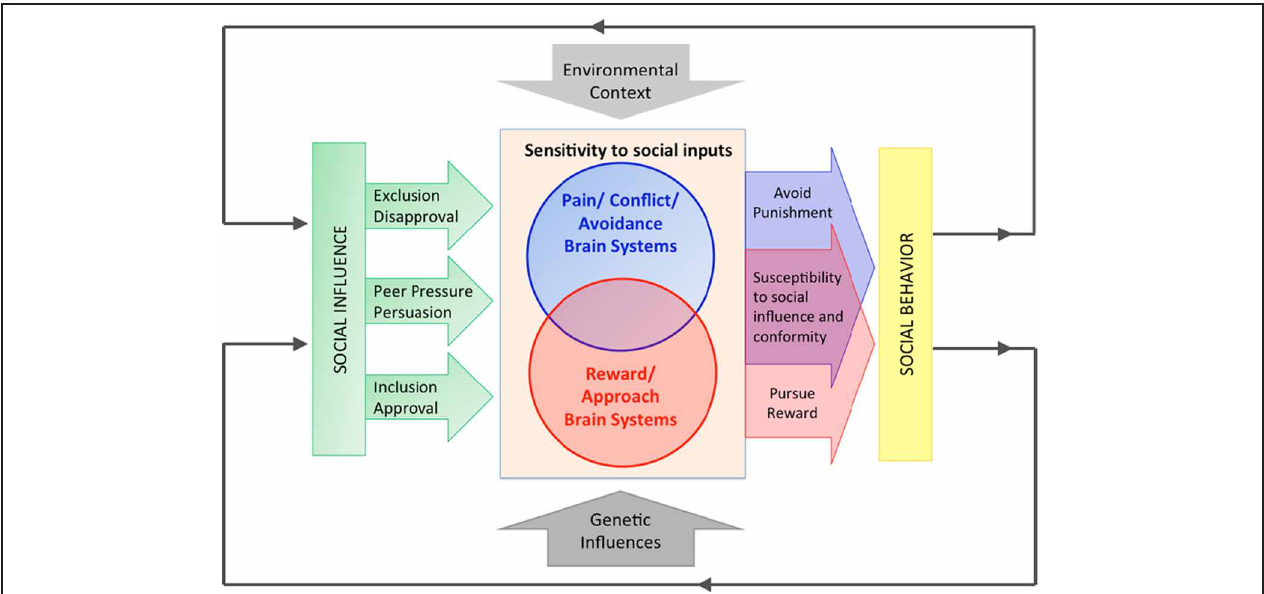
and genetic overlap between reward and punishment processes in the brain, such that some genetic variants that increase sensitivity to social reward are also likely to increase sensitivity to social punishment. As depicted, these neural systems are also moderated by the broader social environment. Finally, although beyond the scope of this Hypothesis and omitted from the figure for simplicity, gene by environment interactions (G × E) are also likely to be critical in shaping the sensitivity to social